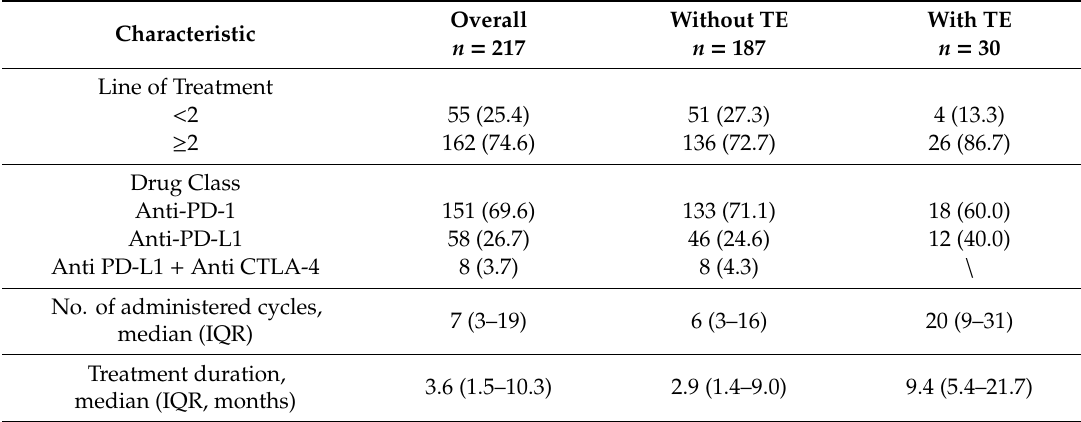
Table 2. Treatment characteristics in the whole case series and according to the presence or absence of TE